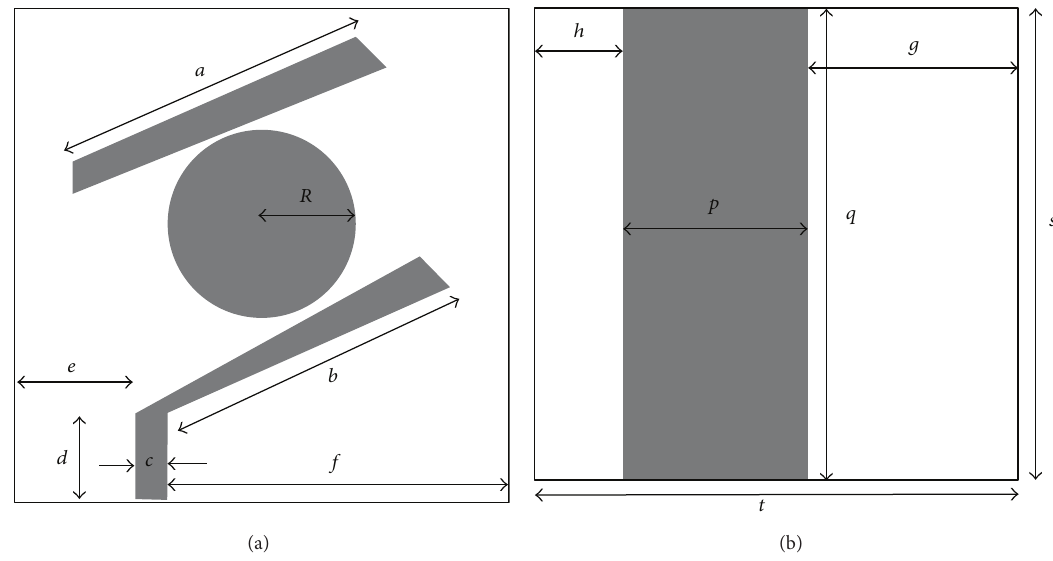
Figure 1: (a) Dimensions of the antenna patch and (b) dimensions of the antenna ground plane.